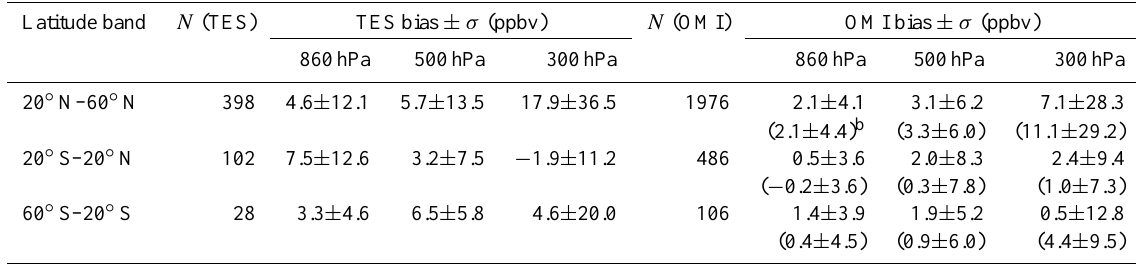
a Mean difference and standard deviation as determined by difference with ozonesonde data for 2005–2007 (see text). N is the number of comparison profiles. b Values in paretheses are the OMI validation statistics if subsampling the OMI/sonde comparisons at the TES observation